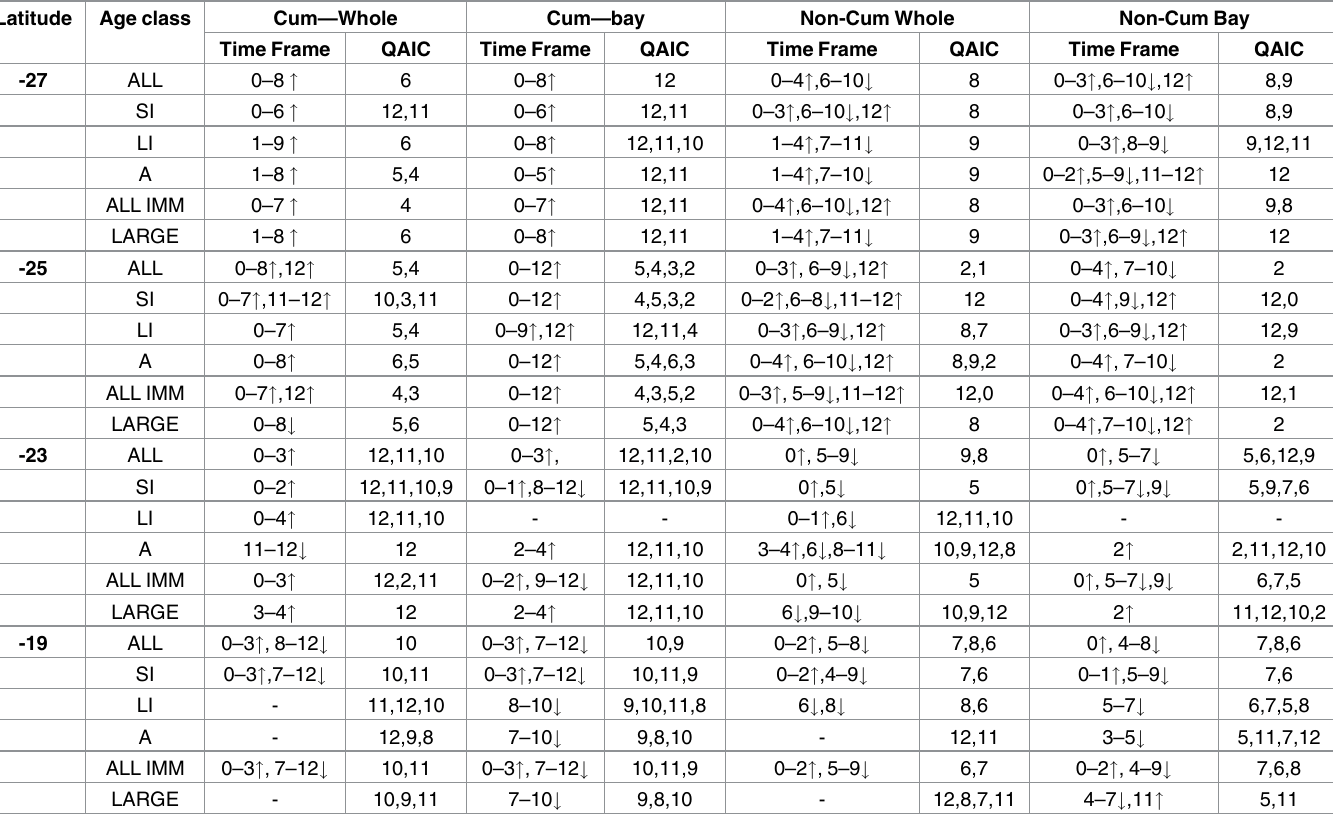
Table 8. Model results for green turtles and monthly averagedaily diurnal air temperature difference. " denotesincreasedstrandings rates with increasedaveragedaily diurnalair temperature difference. # denotesdecreasedstranding rates with increasedaveragedaily diurnalair temperature differ- ence. Age class abbreviations: ALL = all turtles, SI = small immature, LI = large immatures, A = adult-sized, ALL IMM = all immature sized animals(small + large), Large = all large turtles (large immatures + adult-sized). The time frame is reportedin monthly ranges where responses were noted. The values reportedin qAIC are the months with the most significantqAIC